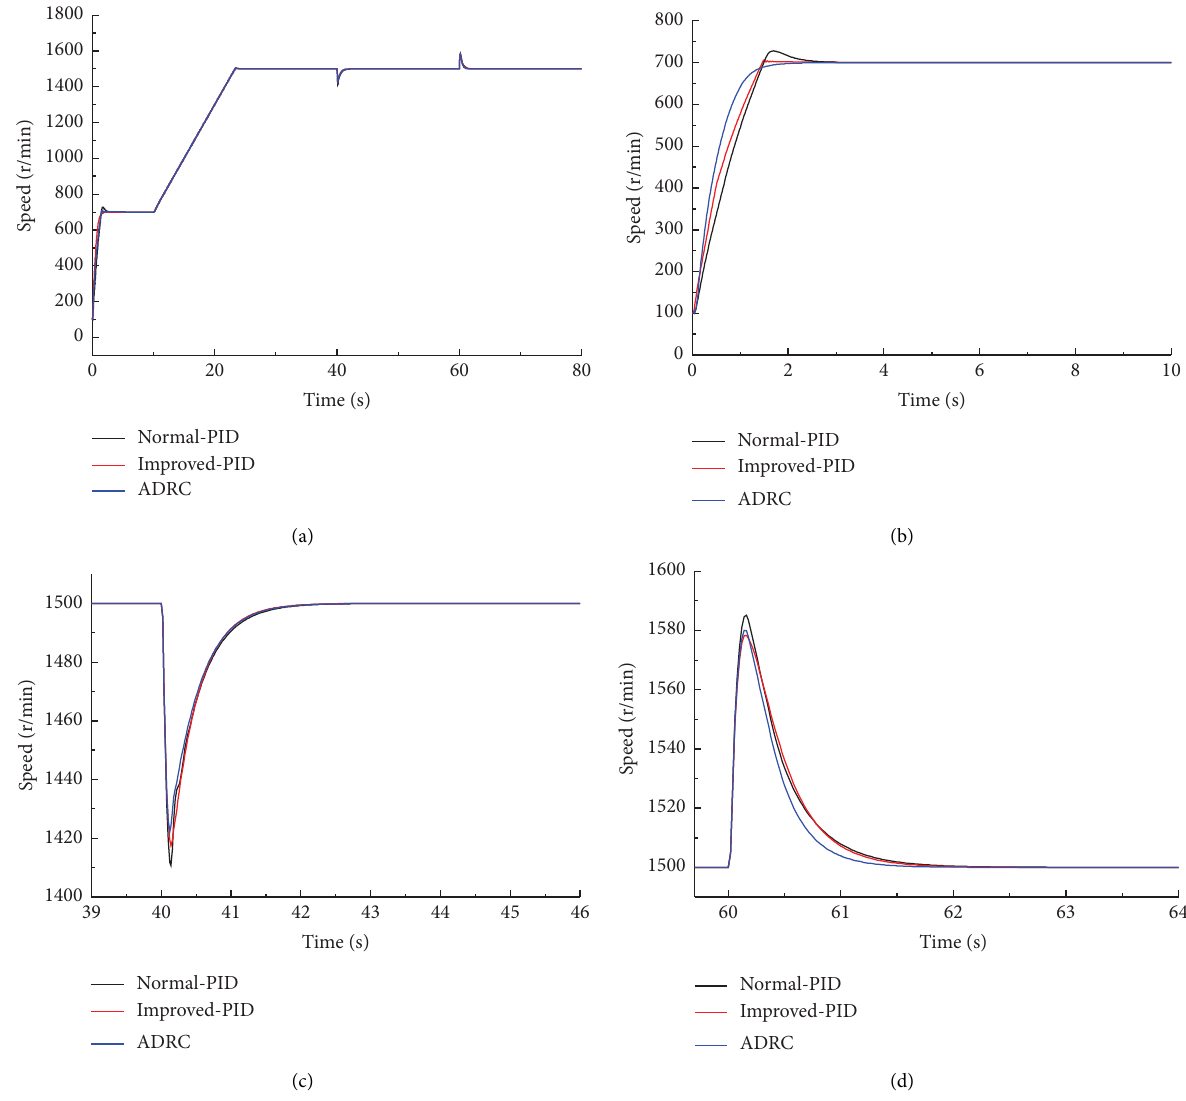
Figure 18: Simulation results of the speed control system with the three control algorithms. (a) Te entire process of the engine speed variations. (b) Te speed variations during engine start-up process. (c) Te speed variations during sudden load process. (d) Te speed variations during sudden unload process.